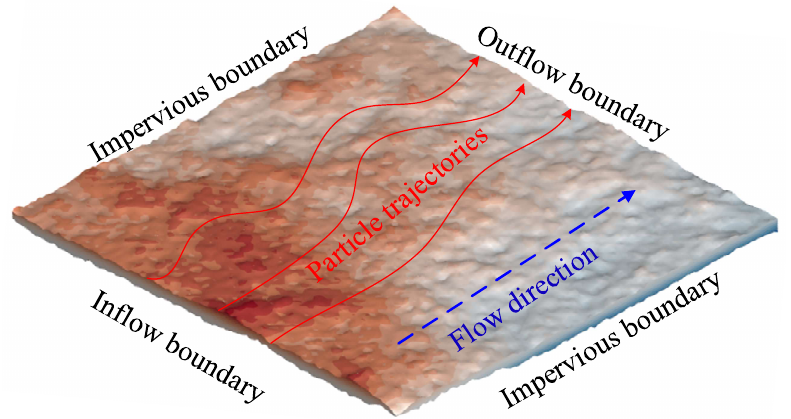
Figure 2. The solute transport model of a rough-walled fracture.